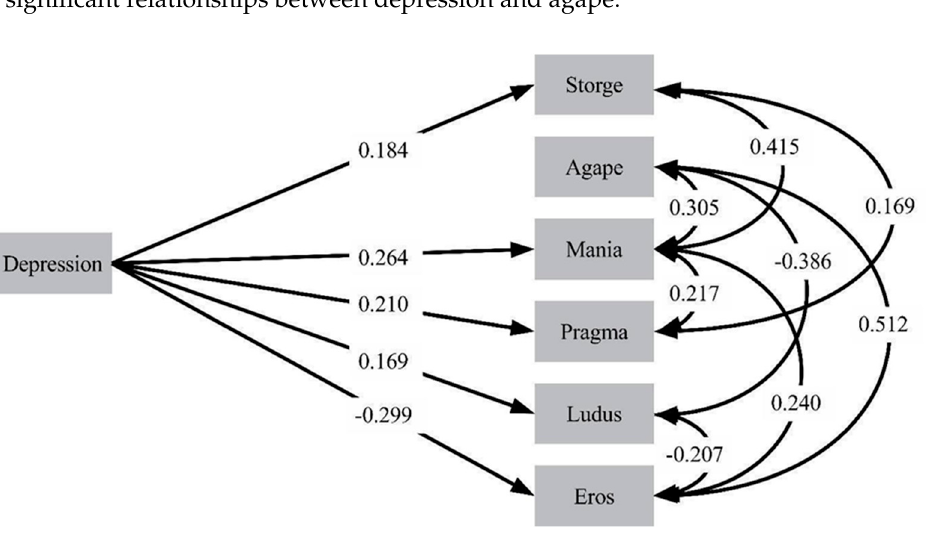
Figure 1. Final path analytic model of the effects of depression on attachment romantic styles in males.